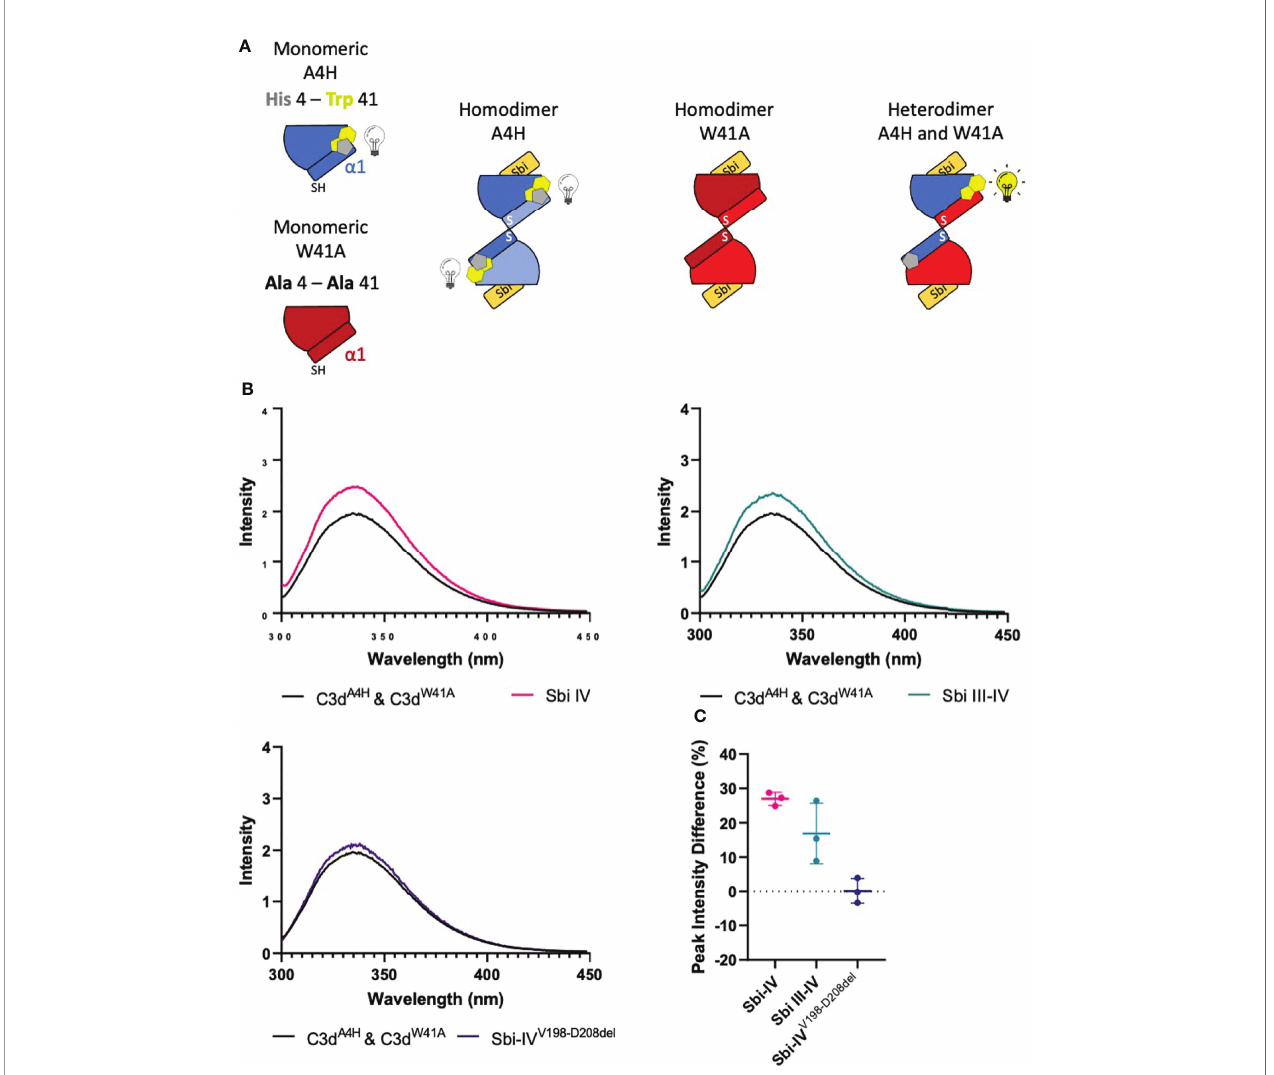
FIGURE 4 | Tryptophan fl uorescence spectroscopic studies with C3d A4H and C3d W41A heterodimers in complex with wild-type Sbi-IV, a truncated Sbi-IV mutant and wild-type Sbi-III-IV. Shown is a schematic depicting the C3d 17C mutants C3d A4H and C3d W41A and highlighting the natural tryptophan W41 (yellow) and histidine H4 (grey) that was introduced to quench W41 ’ s fl uorescence. Homodimers of C3d A4H , C3d W41A are expected to show no change of tryptophan fl uorescence in the event of an N-terminal helix swap, whilst heterodimers of C3d A4H with C3d W41A should display an increase in tryptophan fl uorescence as H4 no longer quenches W41 when the helix swap occurs (A) . Fluorescence spectra of C3d heterodimers in the absence and presence of wild-type Sbi-IV, wild-type Sbi-III-IV and truncated Sbi-IV V198-D208del mutant (B) . Scatter plot showing the tryptophan fl uorescence intensity change with individual readings as well as the mean and SD values, with an average increase of 27%, 17% and 2.5% in the presence of Sbi-IV, Sbi III-IV and truncated Sbi-IV V198-D208del mutant respectively (C)